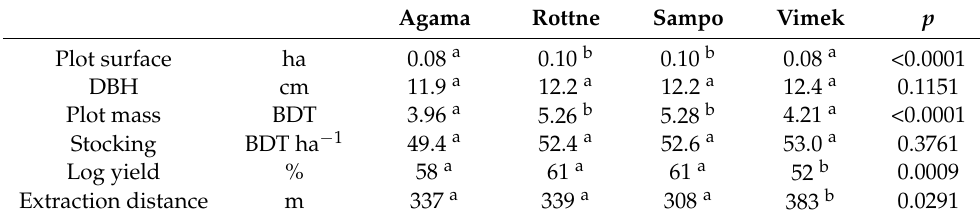
Table 2. Characteristics of the experimental sample plots (mean